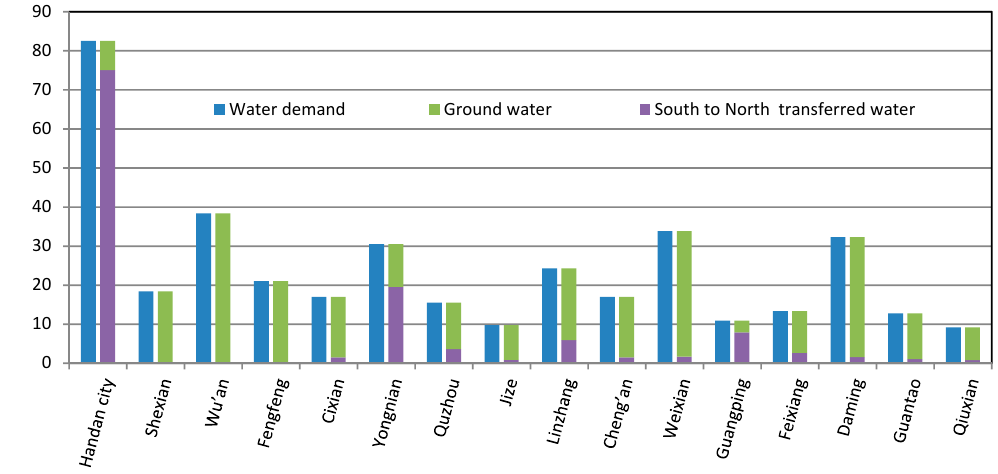
Figure 4. Urban domestic water allocation results in each sub-region in Handan (10 6 m 3 ).